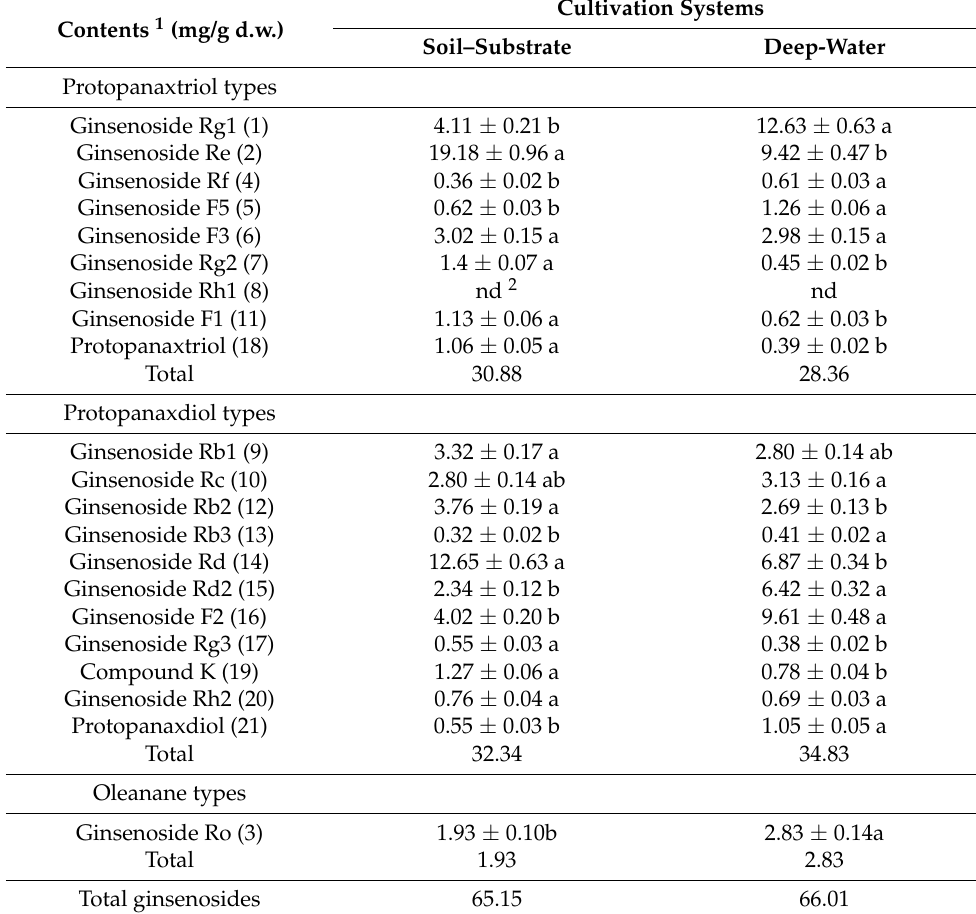
Table 3. Comparison of ginsenoside contents of PGS in different cultivation systems in a plant factory. Contents 1 (mg/g